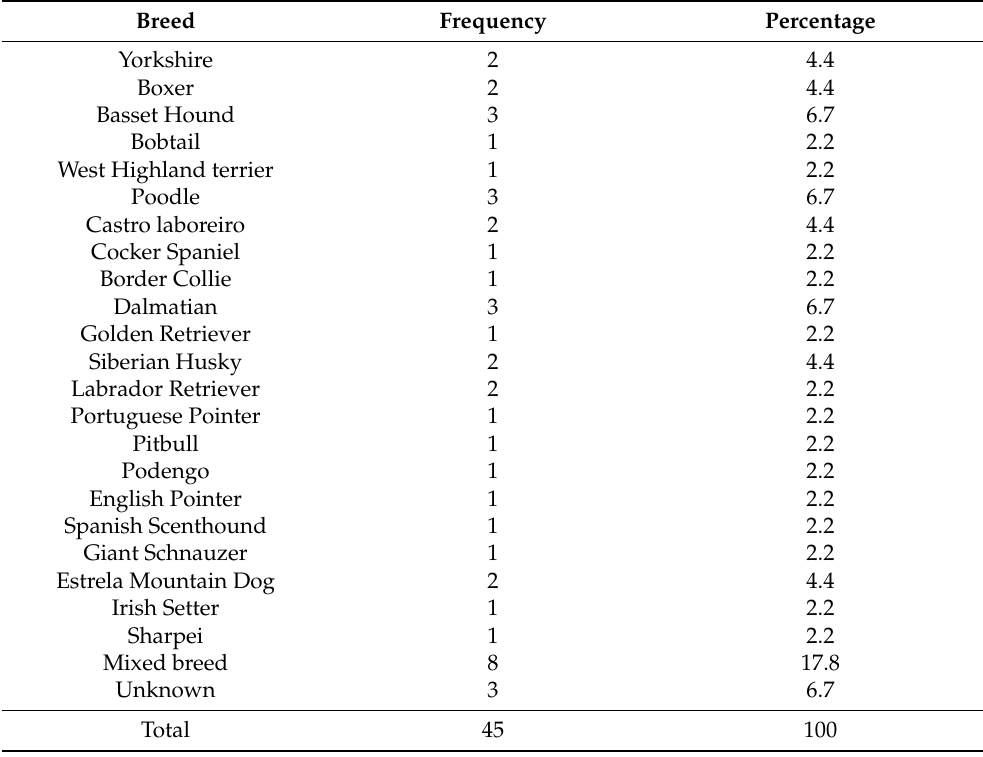
Table 1. Percentage and frequency of dog breeds with SCC.